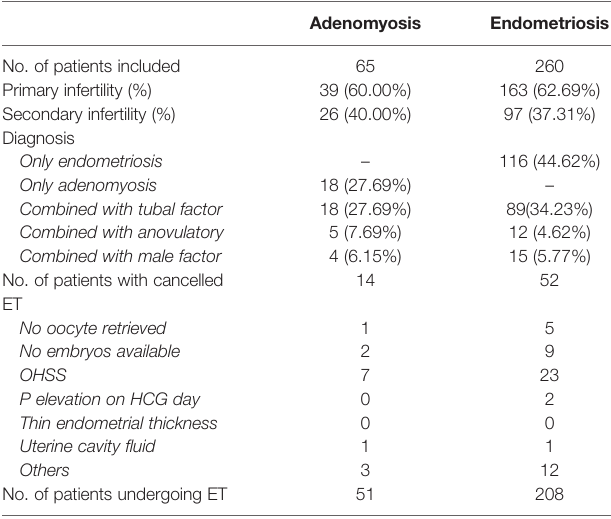
TABLE 1 | Summary of basic information for all patients included in this study.